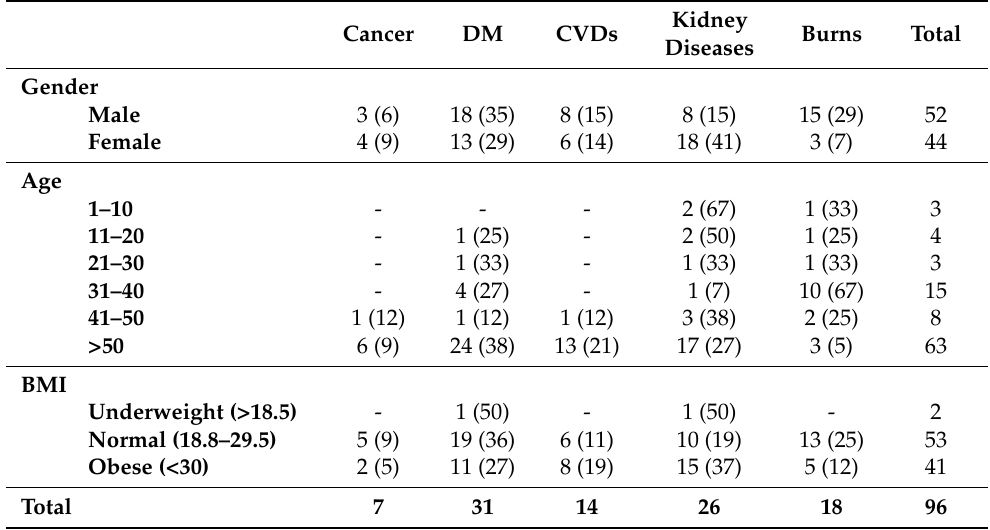
Table 1. Demographic characteristics of the study cohort, a total of 96 patients divided based on their underlying diseases and compared by their gender, age, and body mass index (BMI); results presented in number and